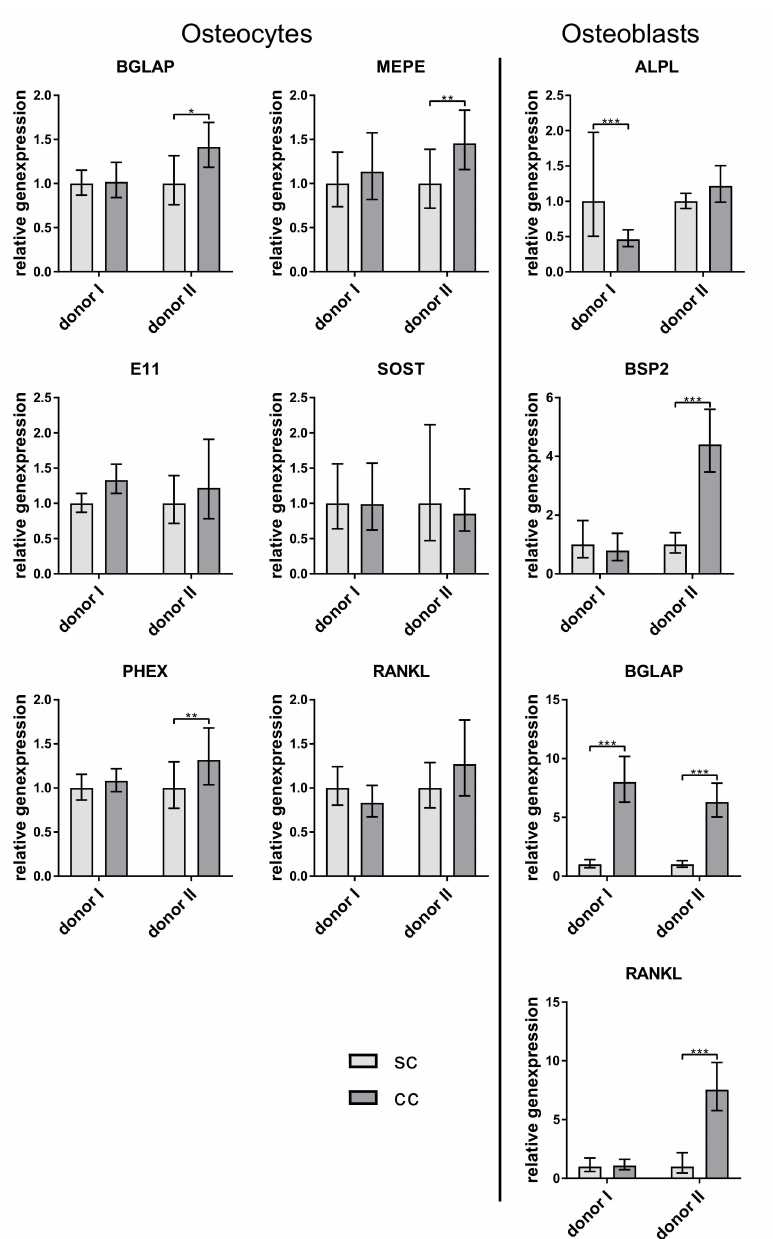
Figure 6. Relative expression of osteocyte and osteoblast markers from single- (sc) and co-cultivated (cc) osteocytes and osteoblasts. Osteocytes were prepared by 2-week di ff erentiation of pre-di ff erentiated osteoblasts in collagen gels (compare Figure 1C). Data from two di ff erent cell donors are presented in one diagram ( n = 3 replicates / donor): mean ± upper / lower limit. Significant di ff erences to the single culture were defined as * p < 0.05, ** p < 0.01, and *** p <